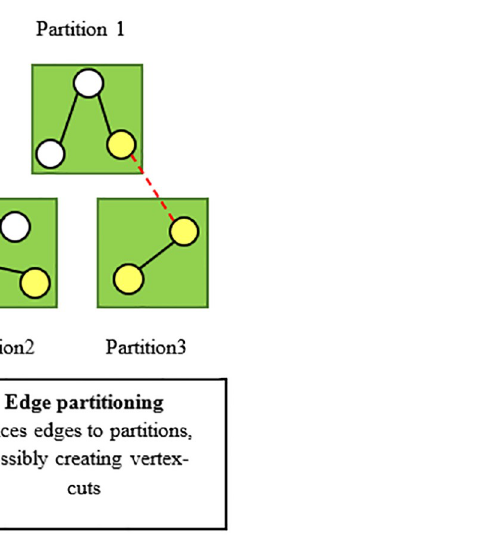
Fig 11. Vertex partitioning and edge partitioning in the Cassandra